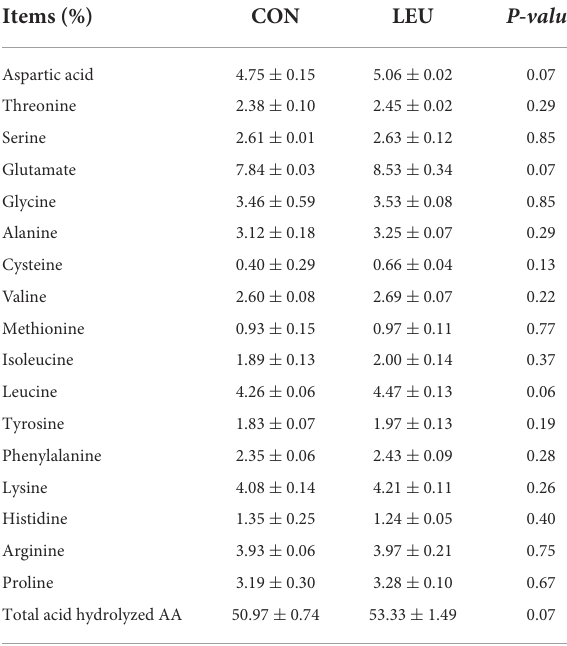
TABLE 7 Effect of leucine supplementation on plasma FAA in boars ( µ mol/L).